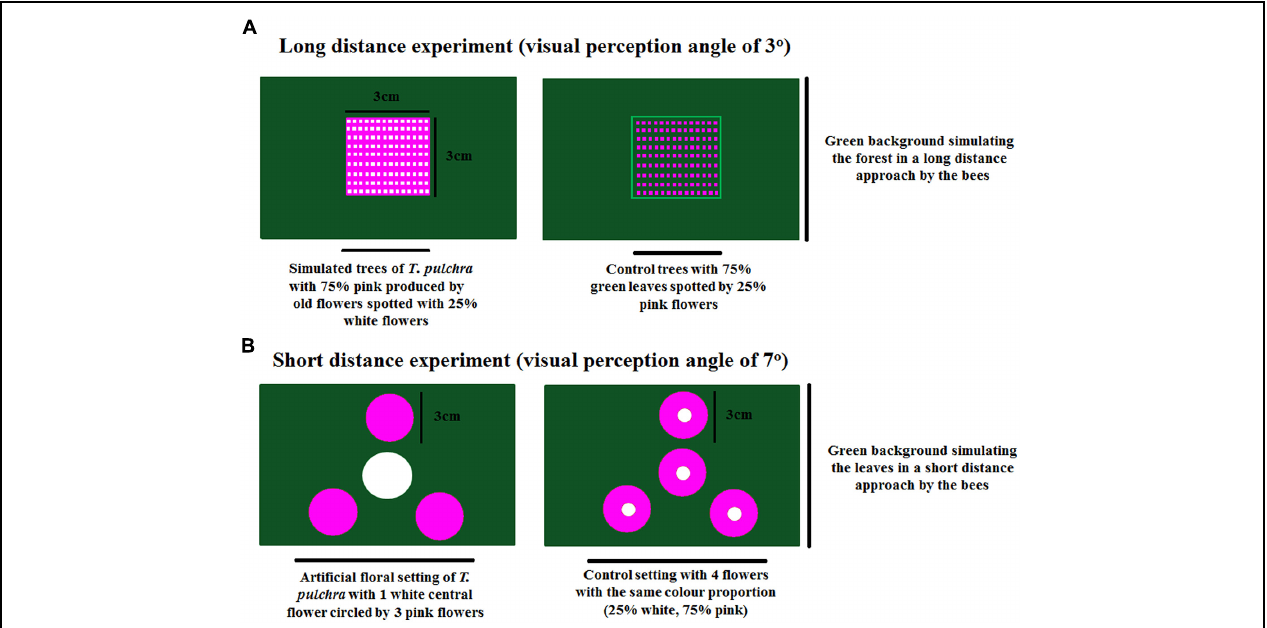
FIGURE 2 | Experimental settings of long-distance experiment (A) and short-distance experiment (B) to test the bee preferences in a Y-maze chamber.